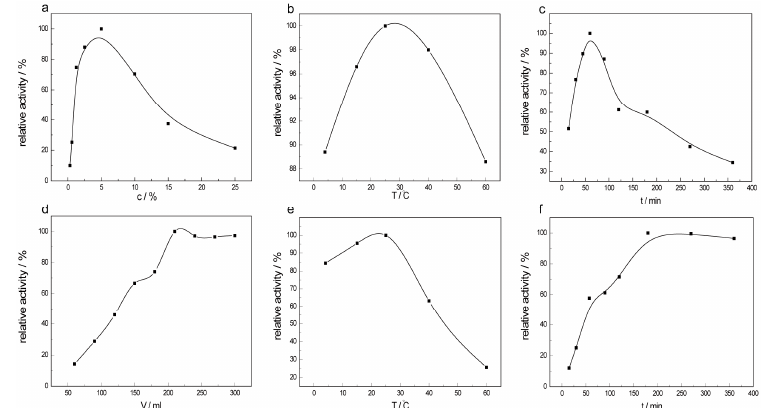
Figure 4. Effects of different immobilized enzyme conditions on the activity of CTS-CAT. ( a ) The effect of the cross-linking agent concentration on enzyme activity; ( b ) the effect of the modification temperature on enzyme activity; ( c ) the effect of the modification time on enzyme activity; ( d ) the effect of the enzyme amount on activity; ( e ) the effect of the immobilization temperature on enzyme activity; and ( f ) the effect of the immobilization time on enzyme activity.